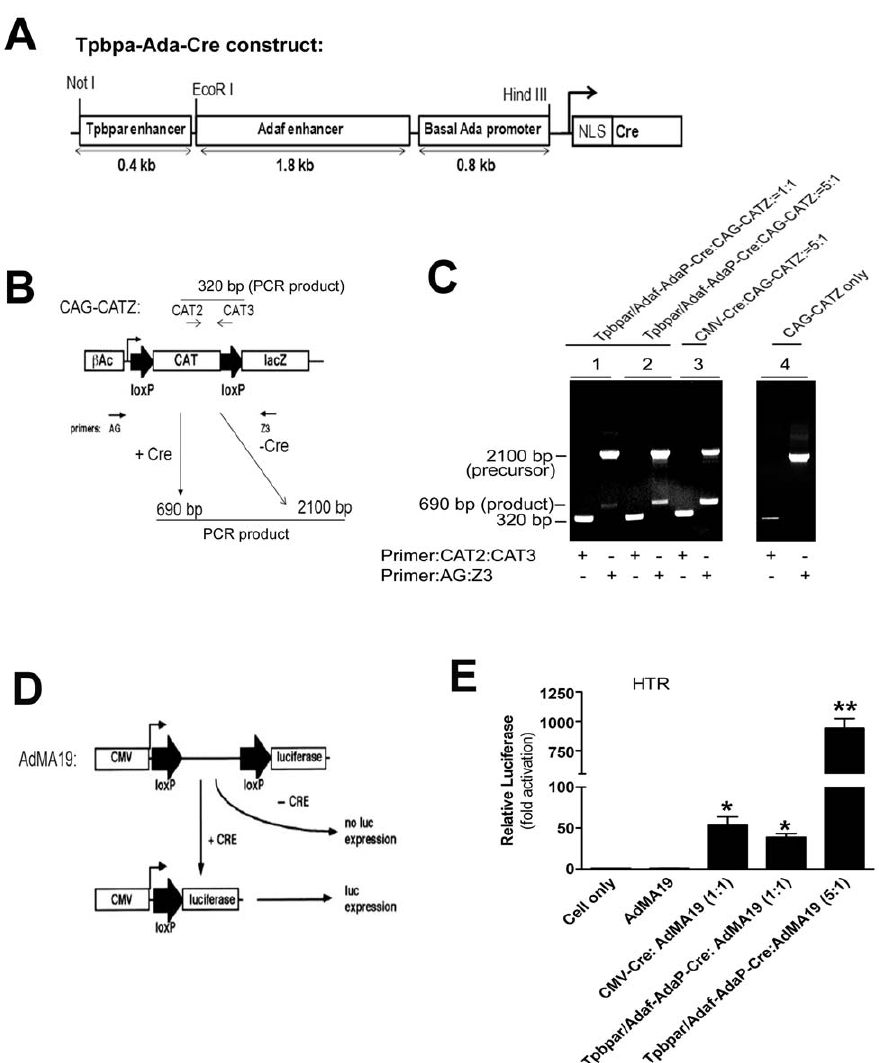
Figure 2. Generation of Tpbpa r/ Ada f- Ada P- Cre chimeric expression vector and invitro analysis of its Cre recombinase activity in human trophoblast cells. ( A ) Structure of p Tpbpa r/ Ada f- Ada P- Cre construct. Tpbpa r/ Ada f chimeric enhancer and Ada basal promoter ( Ada P) were ligated to the sequence encoding Cre cDNA containing a nuclear localization signal (NLS). ( B ) Schematic representation of pCAG-CATZ vector. The PCR primers, primer pair 1 (AG and Z3) were used to monitor Cre-mediated loxP-dependent DNA recombination (2100 bp for parental DNA, 690 bp for the recombined DNA). Primer pair 2 (CAT2 and CAT3) were internal primers used to detect pCAG-CATZ. ( C ) PCR analysis: pCAG-CATZ was transfected alone or together with CMV-Cre or different amounts of Tpbpa r/ Ada f- Ada P- Cre into human trophoblast cells (HTR). DNA was isolated 48 h after transfection and assayed for the presence of the recombination-dependent 690 bp fragment. In the absence of Cre, only the 2100 bp precursor PCR fragment was observed. However, in the presence of Cre, both the 2100 bp precursorand the 690 bp product PCR fragments were detected. The amount of 690 bp PCR fragment observed increased with additional Tpbpa r/ Ada f- Ada P- Cre transfected to the cells. The 320 bp PCR fragment was used to determine that pCAG-CATZ was transfected into the cells. ( D ) Schematic representation of AdMA19 vector. Spacer interposed between the loxP sites precludes efficient lucifearse expression in the absence of the Cre recombinase. ( E ) Luciferase analysis. AdMA19 vector was transfected with CMV- Cre (CMV-Cre/AdMA19 ,1:1), different amounts of Tpbpa r/ Ada f- Ada P- Cre ( Tpbpa r/ Ada f- Ada P- Cre/AdMA19,1:1 or 5:1 ) or alone. Cellular extracts were isolated 48 h after transfection and luciferase activity was measured. All data are expressed as mean 6 SEM. n=6. * P , 0.05 versus cells transfected with AdMA19 construct only. ** P , 0.05 versus Tpbpa r/ Ada f- Ada P- Cre/AdMA19,1:1